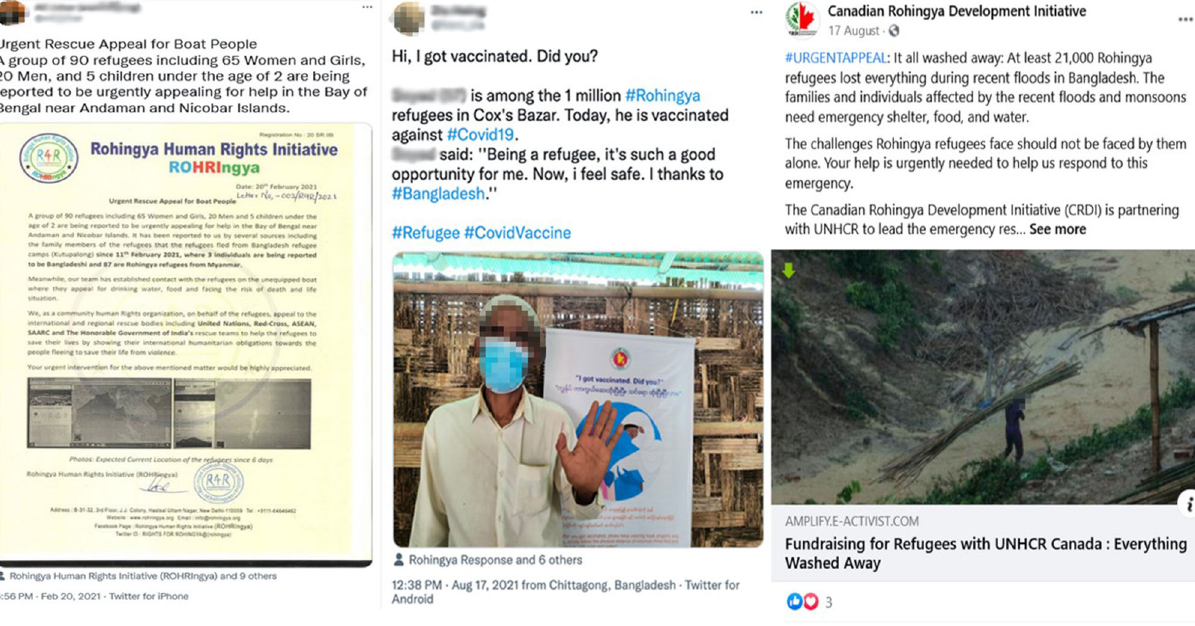
Fig. 8 Social networking sites have emerged as a vital source of information and community services. Rohingya activists leveraging social media to disseminate relevant